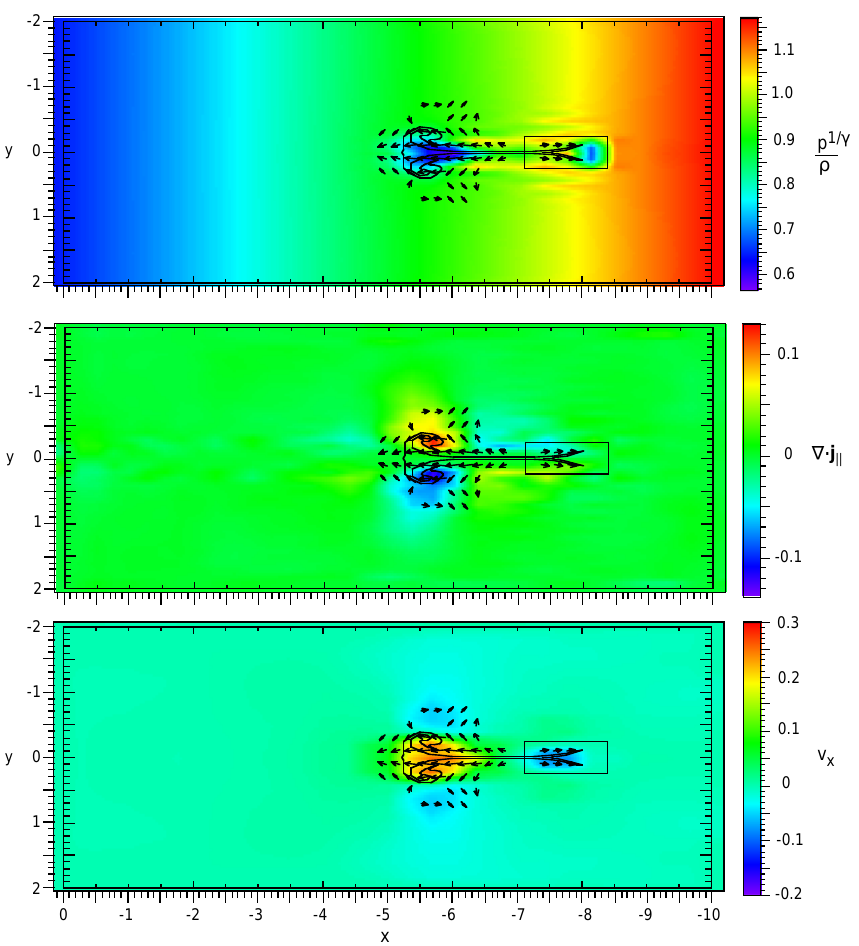
Fig. 18. Bubble properties in the equatorial plane at t = 15 for a depleted flux tube with y m = 0 . 2. The top panel shows the entropy function s = p 1 /γ /ρ , the center panel the diversion of the parallel current density ( ∇· j k ), integrated over z , and the bottom panel shows the x component of the flow speed. Black arrows represent velocity vectors with v> 0 . 05, and the black contours outline the initial bubble boundary (rectangle) and its deformation at t =